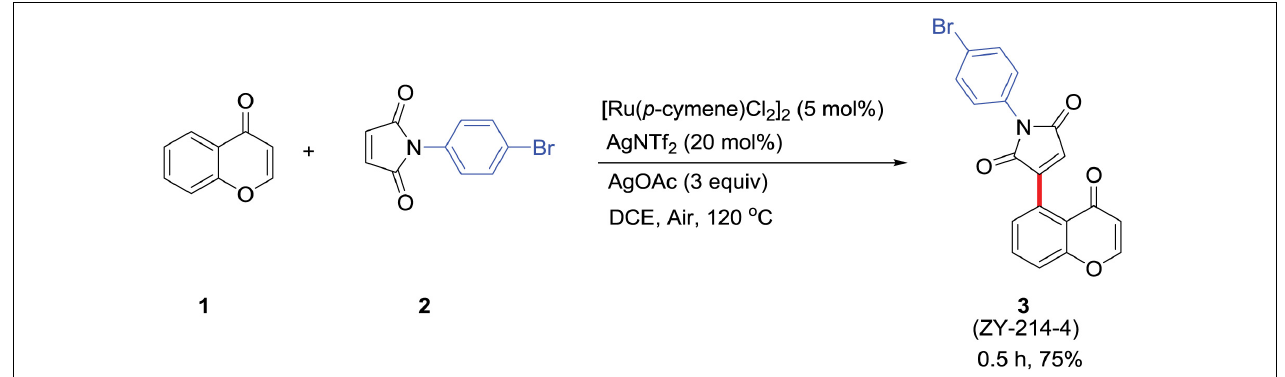
FIGURE 1 | Procedure for ZY-214-4 synthesis. (1) Chromone; (2) maleimide; (3) ZY-214-4.